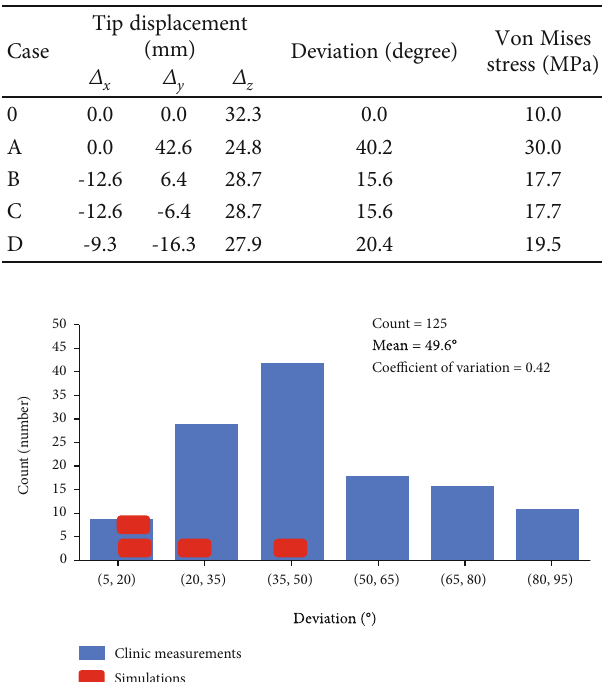
Figure 6: Von Mises stress distribution in tunica albuginea with plague. Case A. Table 2: Summary of simulation results.